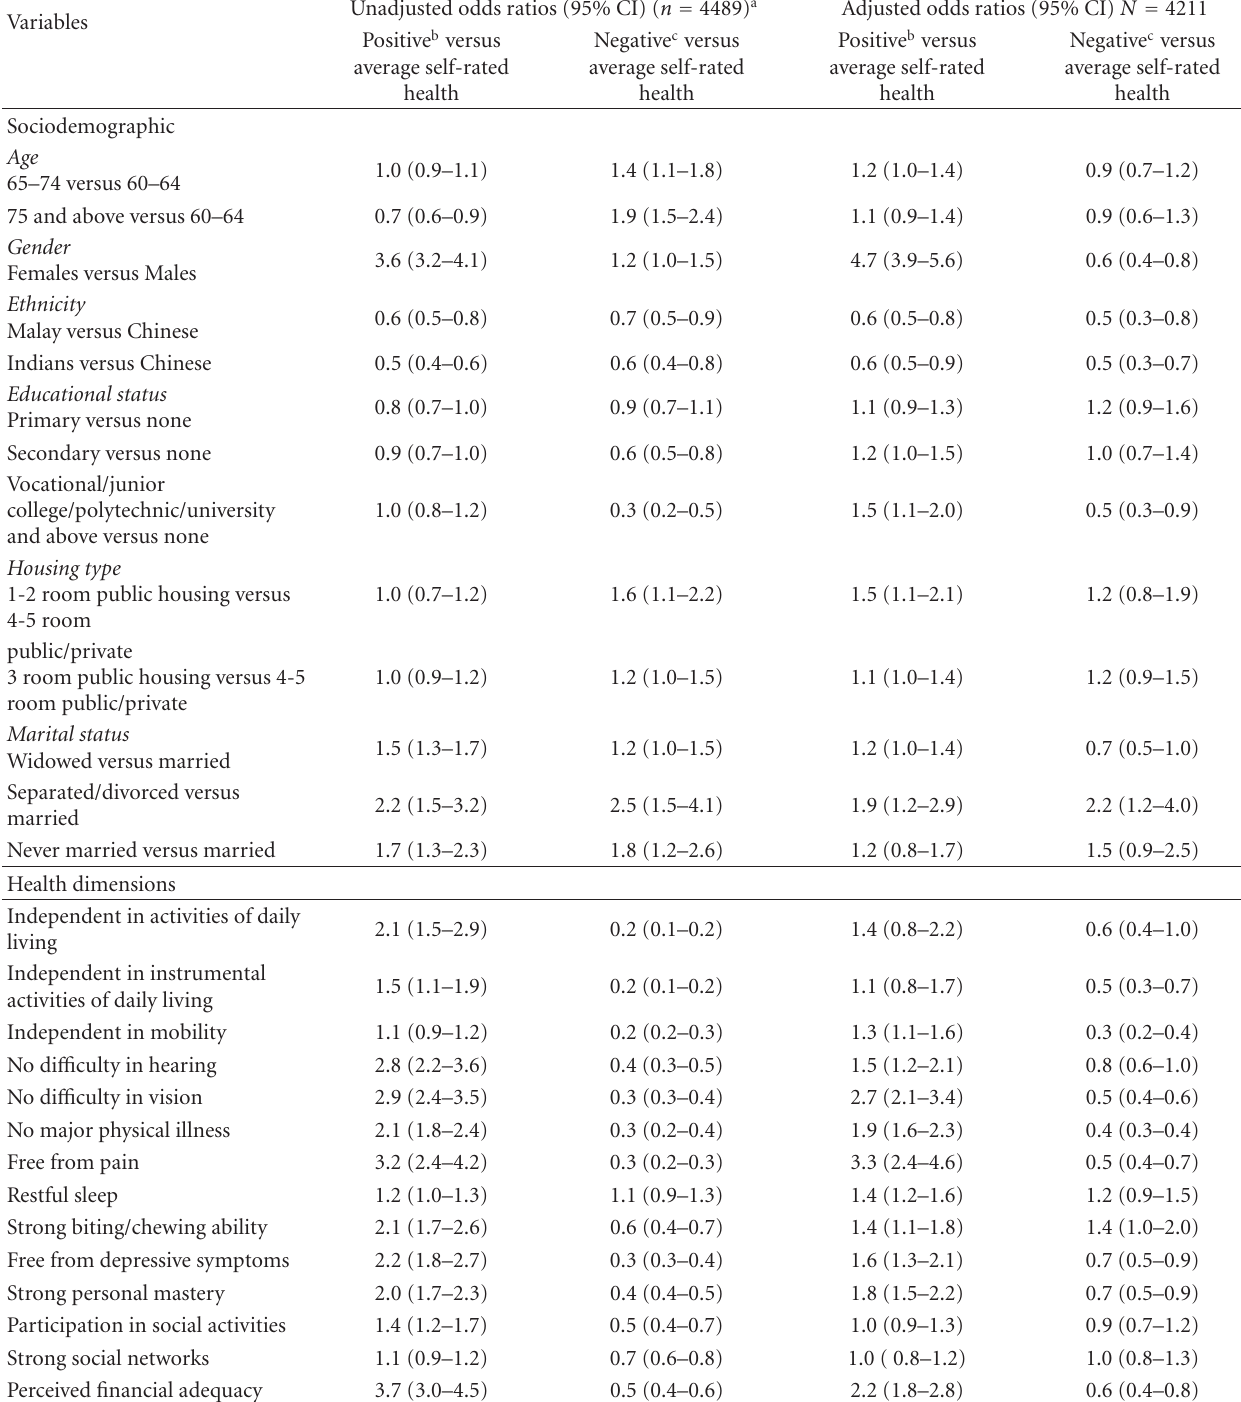
Table 2: Unadjusted and adjusted odd ratios for positive and negative self-rated health among older